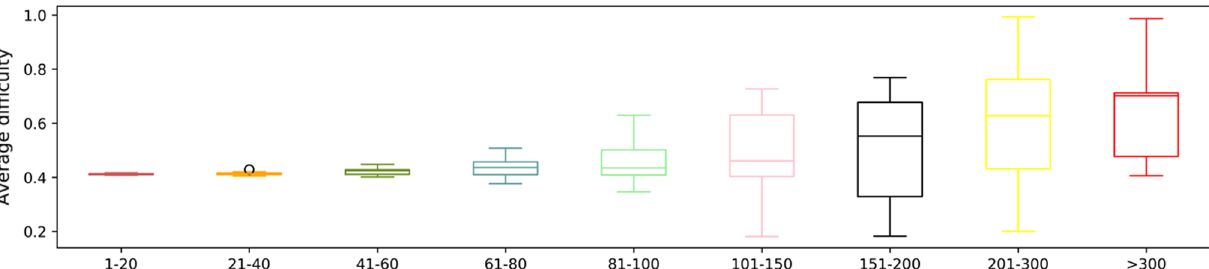
Fig. 8 Average difficulty difference of the two consecutive problems in each session